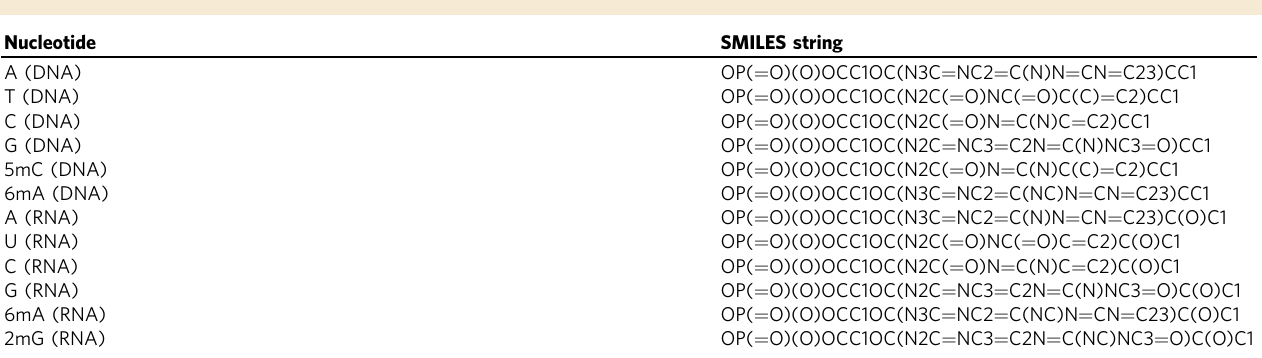
Table 1 SMILES strings of individual